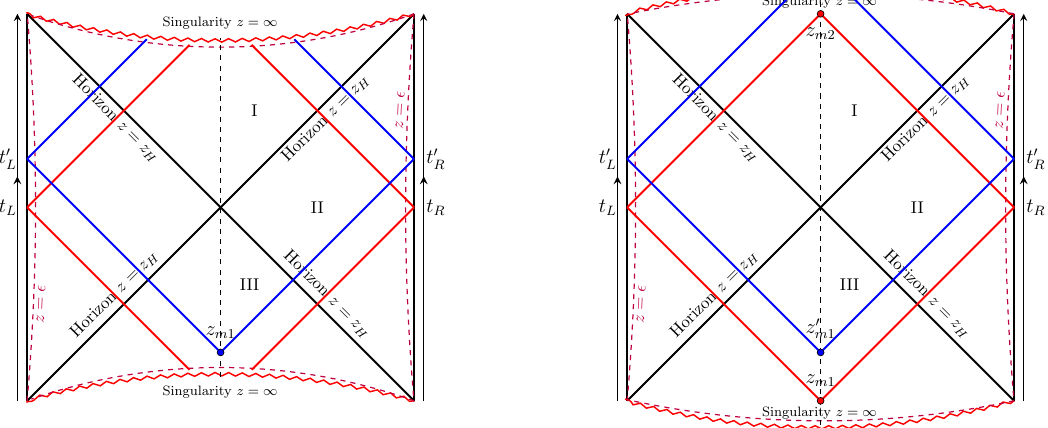
Figure 12 . The WdW patch at the boundary time t = 0 (red line) and t > 0 (blue line). The critical time t is the time where the null past joint of WdW patch locates exactly at the past c singularity. Left: the case with t 0 . Right: the case with t 0 c > c <